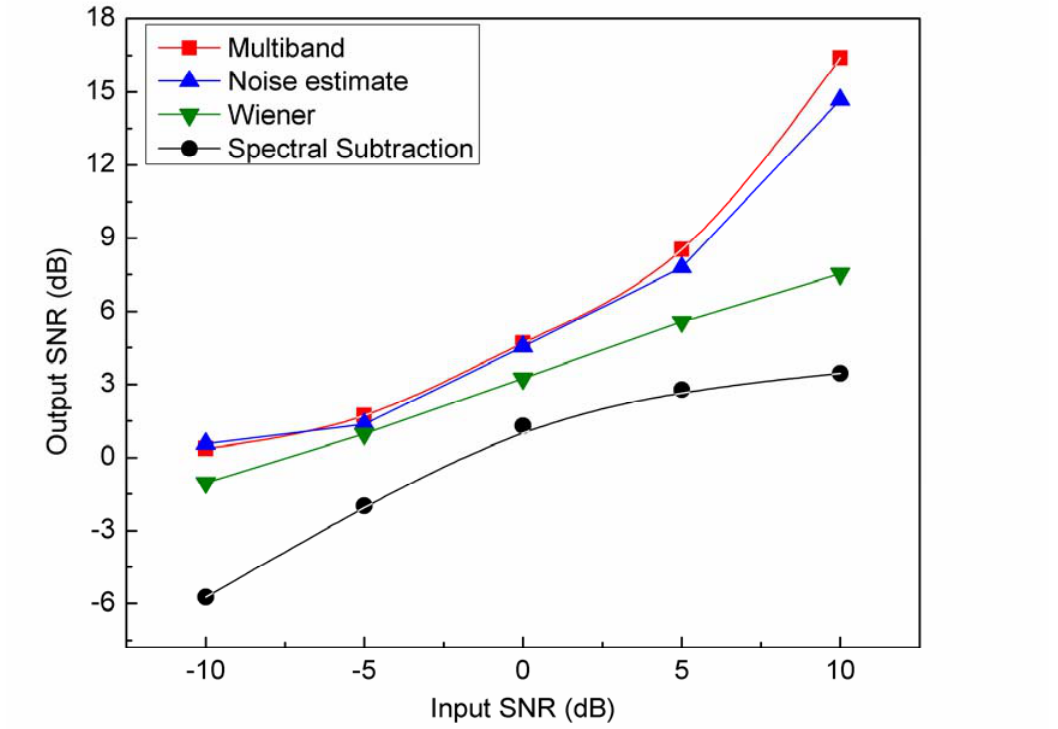
Figure 4. SNR results for white noise case at -10, -5, 0, +5, and +10 dB SNR